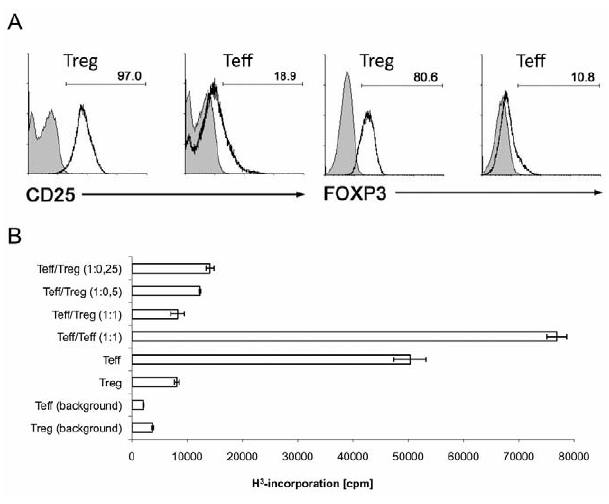
Figure 1. Phenotype and function of exvivo expanded Tregs and Teffs. ( A ) Allo-reactive CD4 + CD25 hi Tregs expressed high levels of CD25 (95–99%) and Foxp3 (80–90%). Allo-reactive CD4 + CD25 2 Teffs showed low levels of CD25 and Foxp3 expression. ( B ) T cell proliferation and suppressive capacity of Tregs was accessed by 3 H (thymidine)- incorporation on day 3 in triplicates prior each kinome analysis. Expanded Tregs consistently suppressed the proliferation of corre- sponding Teffs. Data shown are representative for Teffs and Tregs used in this study.